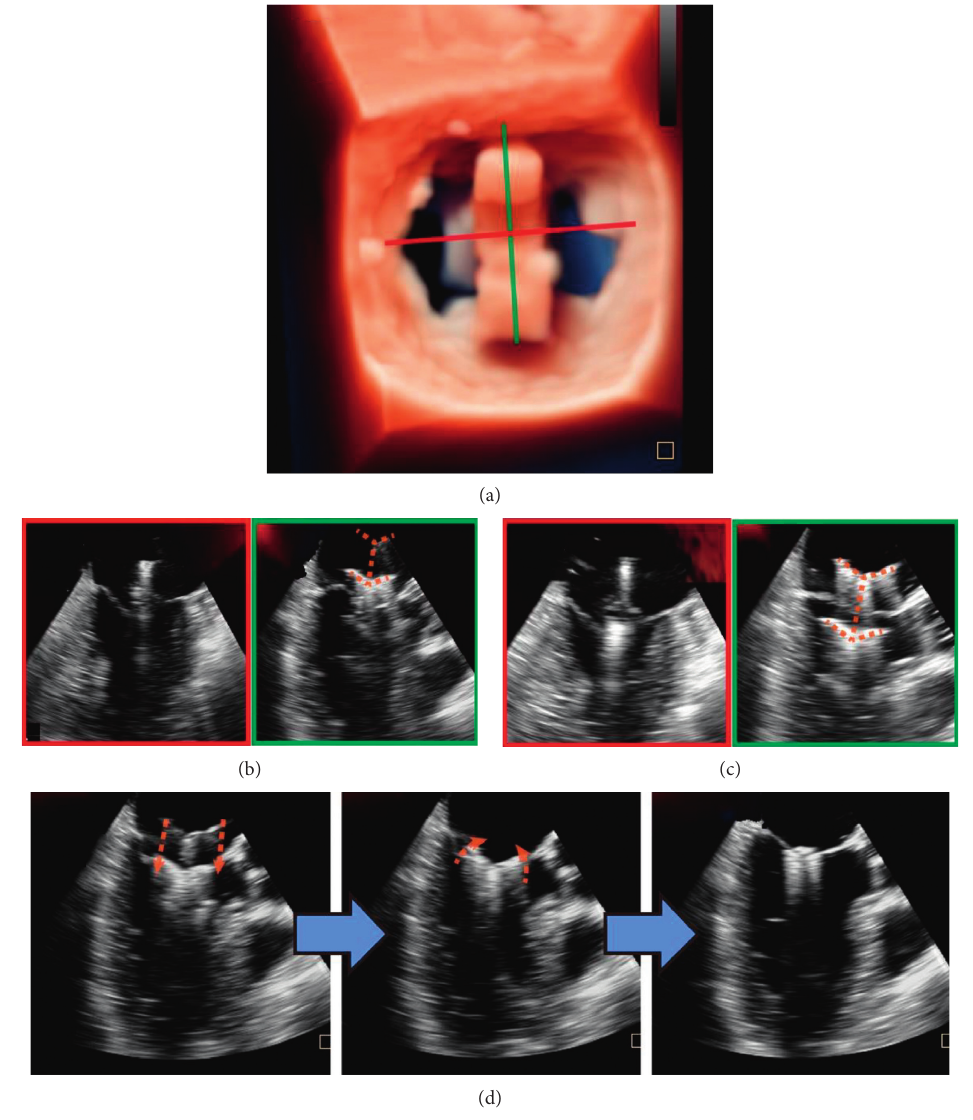
Figure 4: Advancement and adjustment of the clamp. 3D enface view (a) and X-plane view (b) show that the clamp is located in the center of the MV orifice and perpendicular to the MV closure line. The full length of the clamp arms (c) (orange dotted line) is seen in the long-axis view, and in the ME-commissural view, no clamp arms but the delivery rod should be seen. Next, the rear clamp is retracted into the LV, and the clamp orientation is reassessed with lowered gain settings (right: oblique perspective). (d) Leaflet